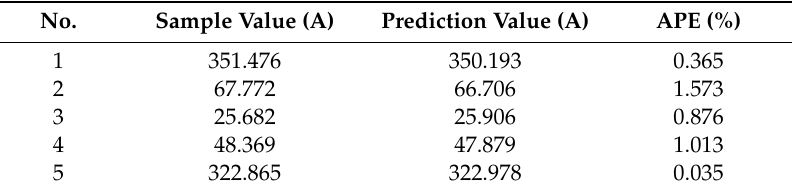
Table 2. Prediction results on the test set.